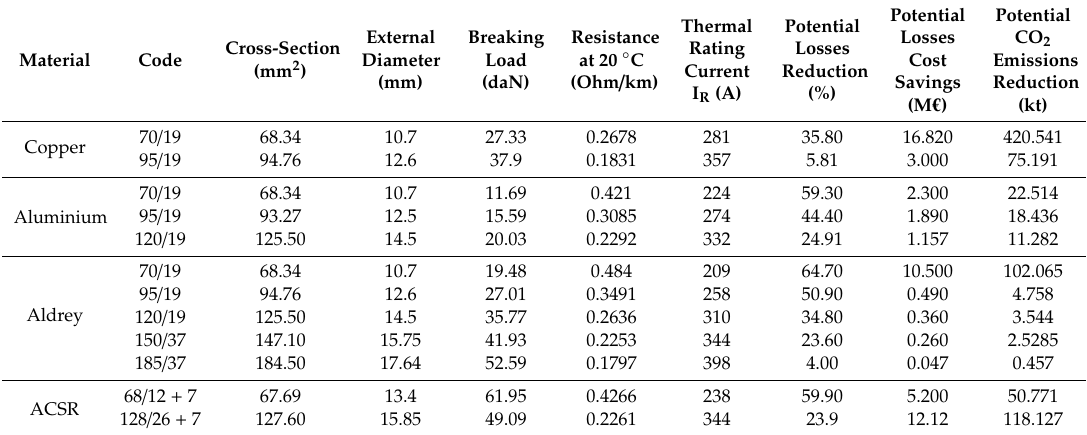
Table 13. Potentially replaceable distribution network